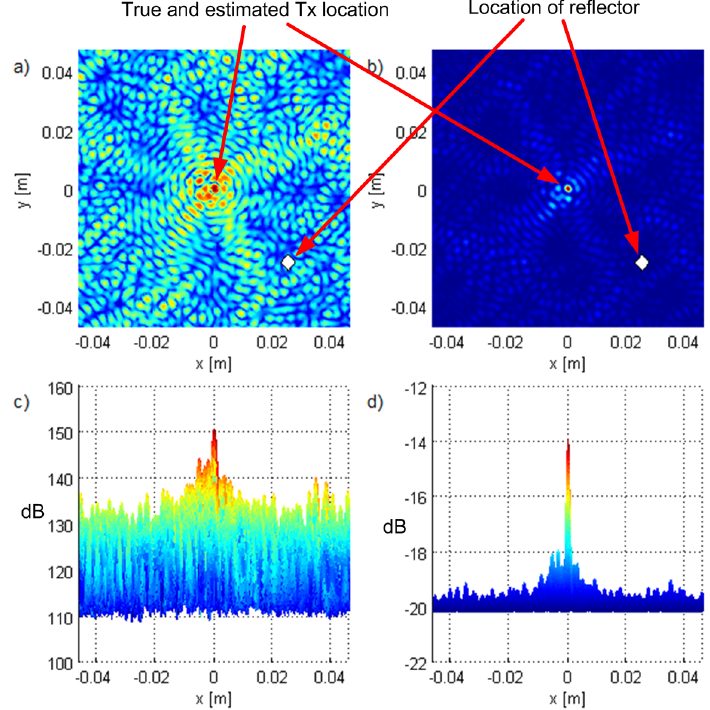
Figure 15. One user with a cluster of scatterers scenario: top views of the criterion functions for G 90 and T 1 for ( a ) ML-US, ( b ) SCM-MUSIC, and the corresponding side views in ( c , d ) with the magnitude in